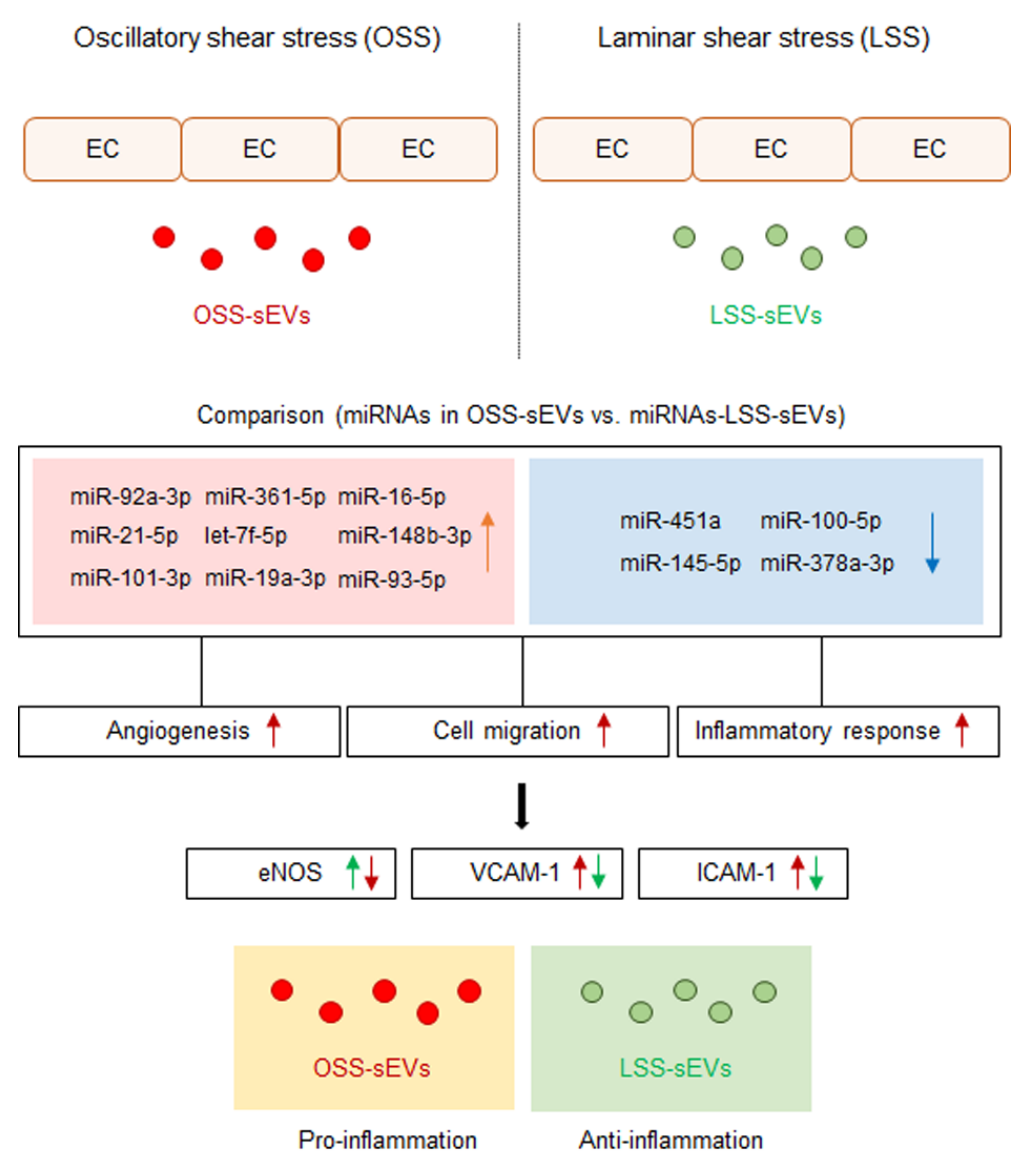
Figure 7. Schematic of the proposed role of EC-sEVs under different FSS condition in ECs. MiRNA profiles in EC-sEVs secreted under atheroprone OSS and atheroprotective LSS conditions are different from each other. Plus, their major regulatory biological processes are involved in angiogenesis, cell adhesion, and inflammatory response in ECs. In addition, LSS-sEVs have anti-inflammatory properties, whereas OSS-sEVs have the opposite effect in ECs.